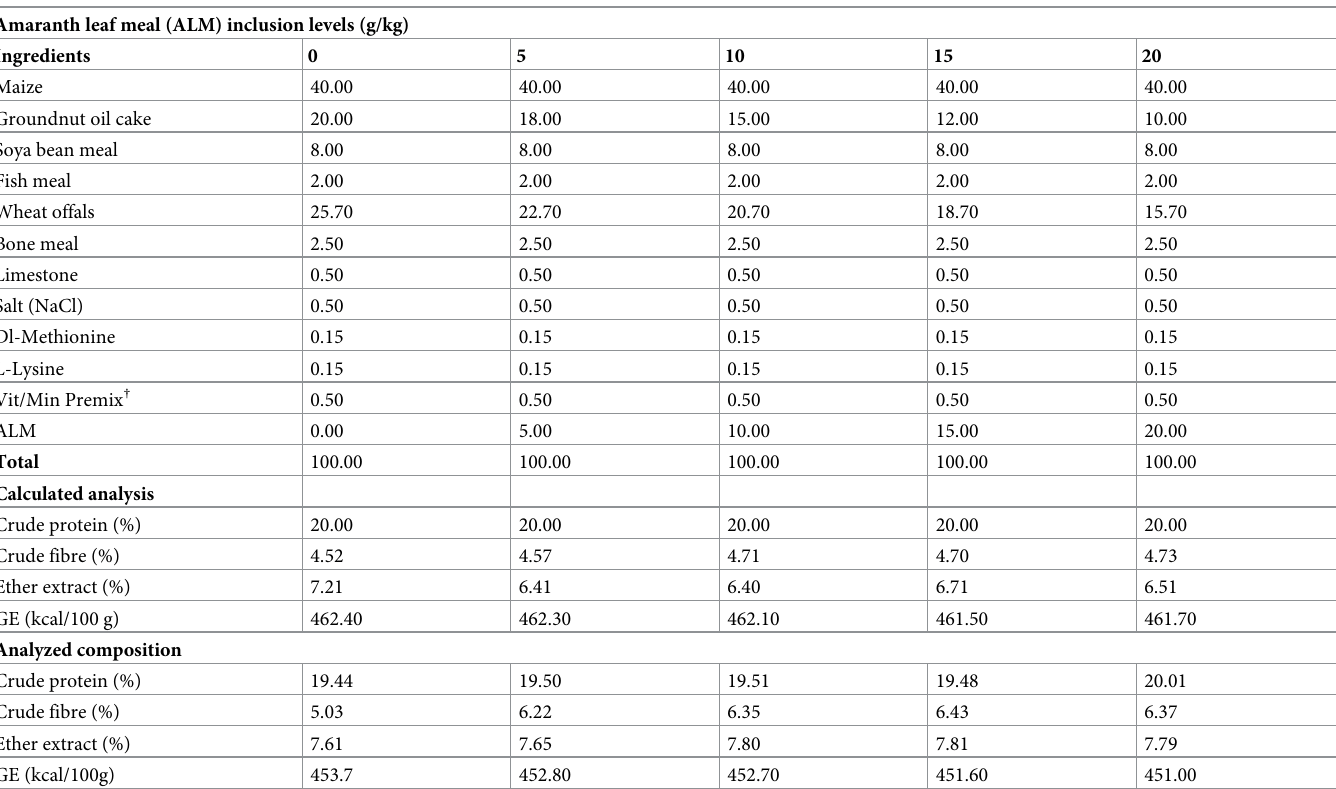
† The ingredients contained in the vitamin–mineral premix were as follows (per kg of diet): vitamin A 12000 IU, vitamin D3 3500 IU, vitamin E 30.0 mg, vitamin K 3